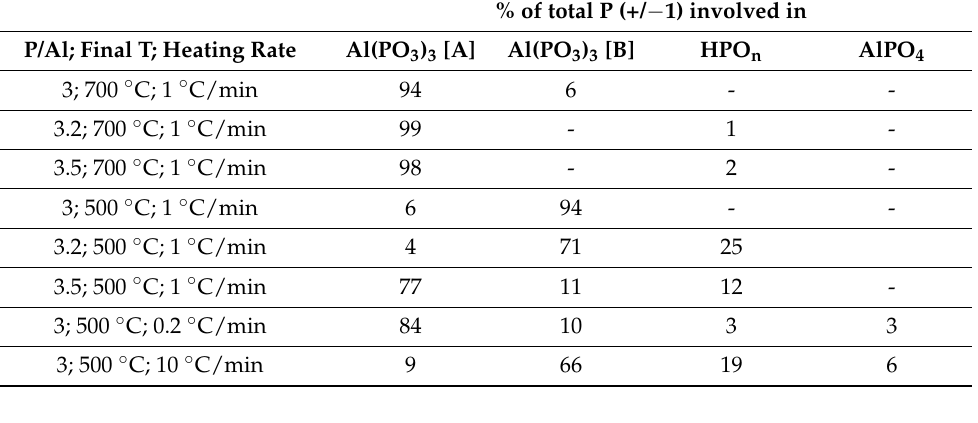
Table 5. Percentage of P signals deduced from the 31 P NMR spectra decompositions. Final T: final temperature. The errors on the quantification are +/ − 1%. Only the data obtained on binders prepared with a dwell time of 1 h are reported here.